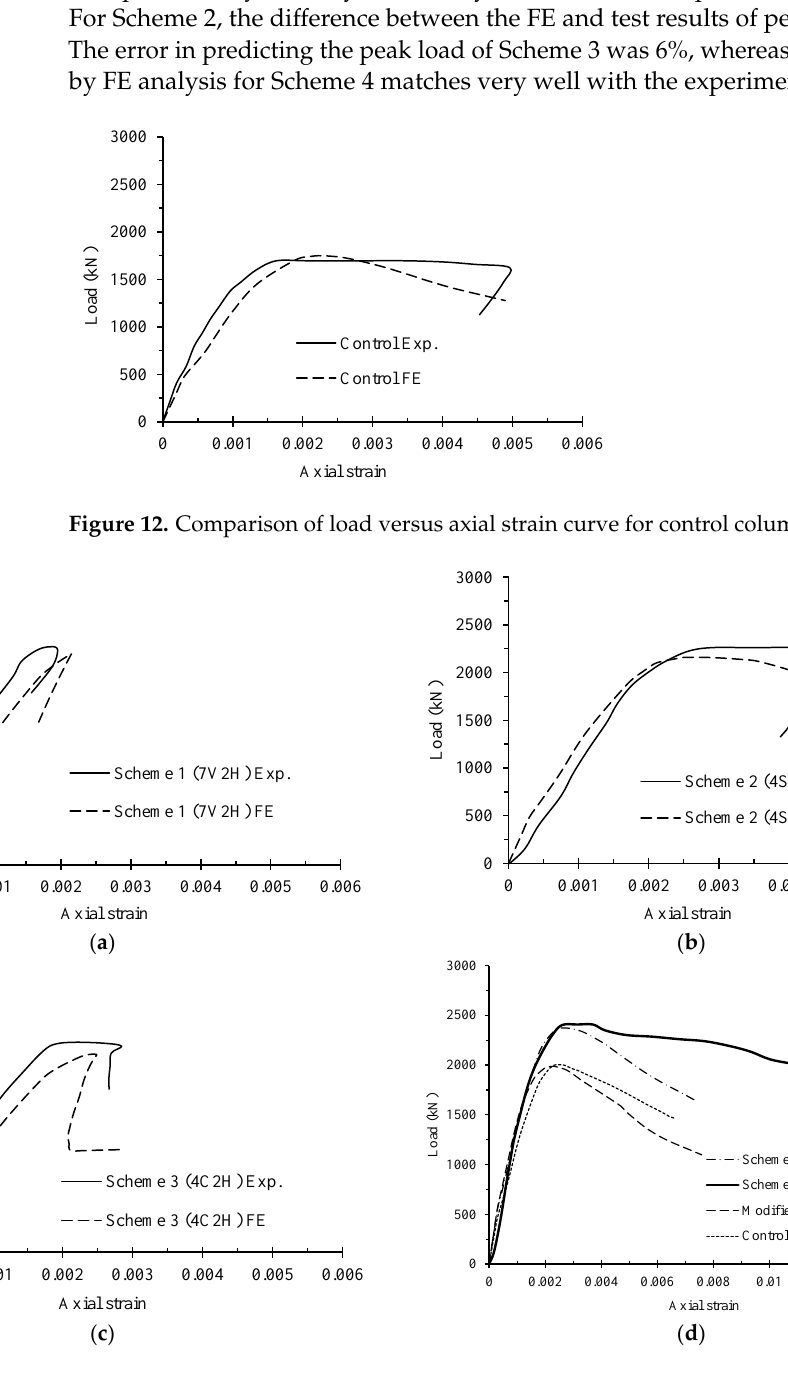
Figure 11. Comparison of finite element model with experimental results of a control column of reference [20].